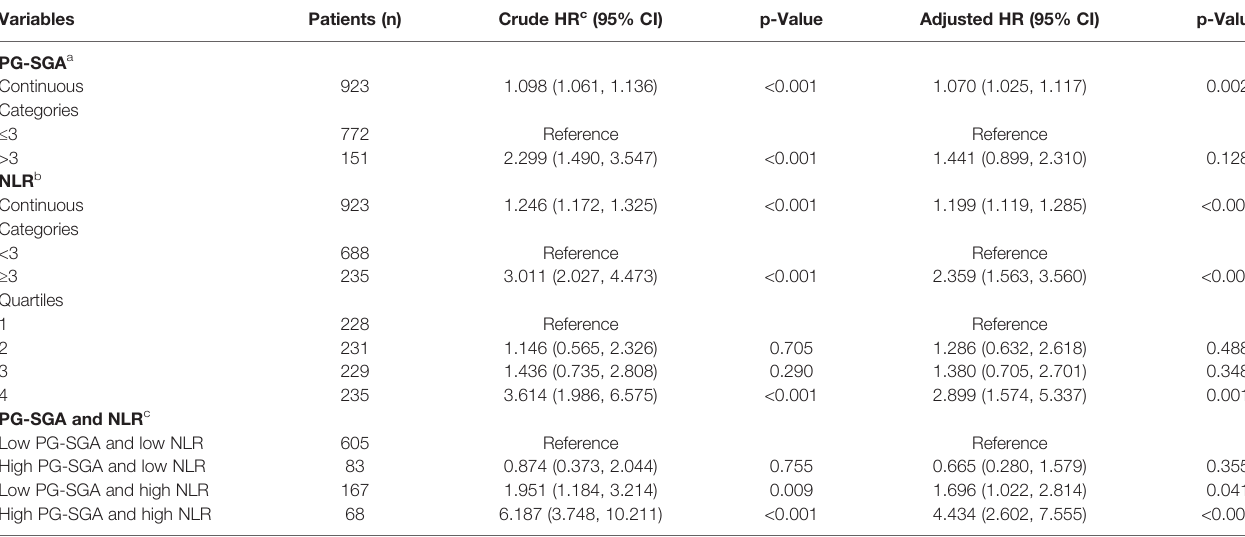
TABLE 3 | Association between PG-SGA or NLR and OS in patients with NPC undergoing chemoradiotherapy. Variables